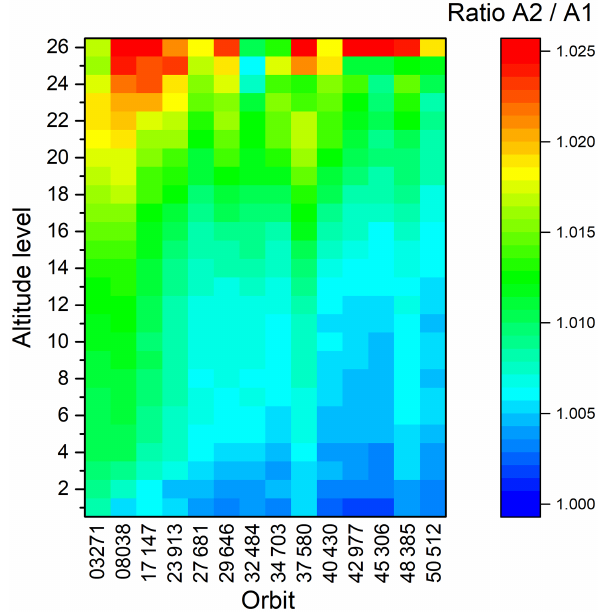
Figure 12. Ratio of calibrated spectra of channels A2 and A1. Alti- tude 26 corresponds to about 67km, altitude 1 to about